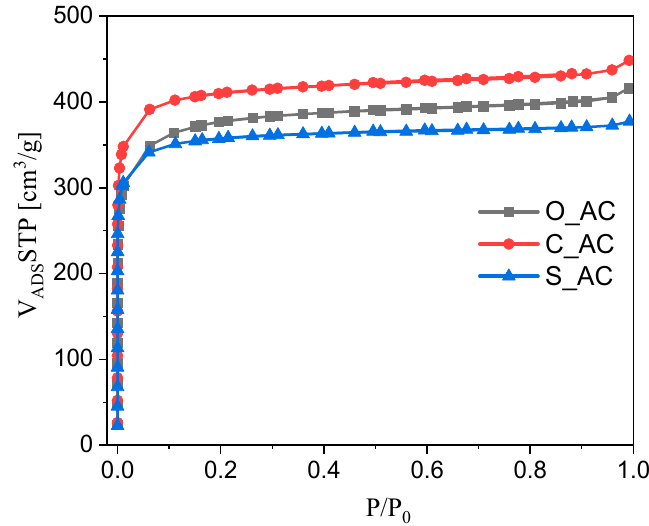
◦ C for tested activated carbons.